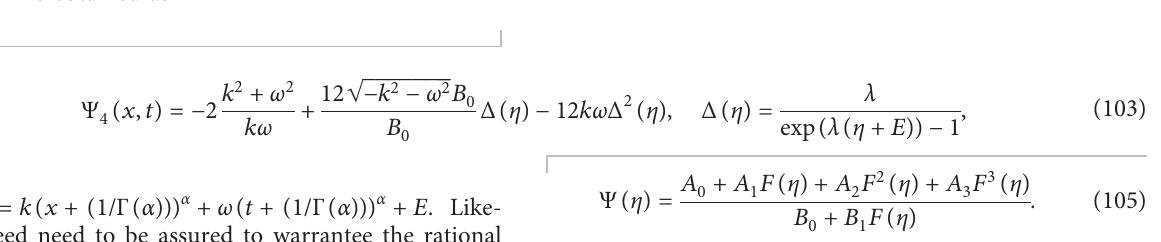
Figure 6: The plot of (98) Ψ plot (red α � 0 . 5, blue α � 0 . 75, and green α � 0 .